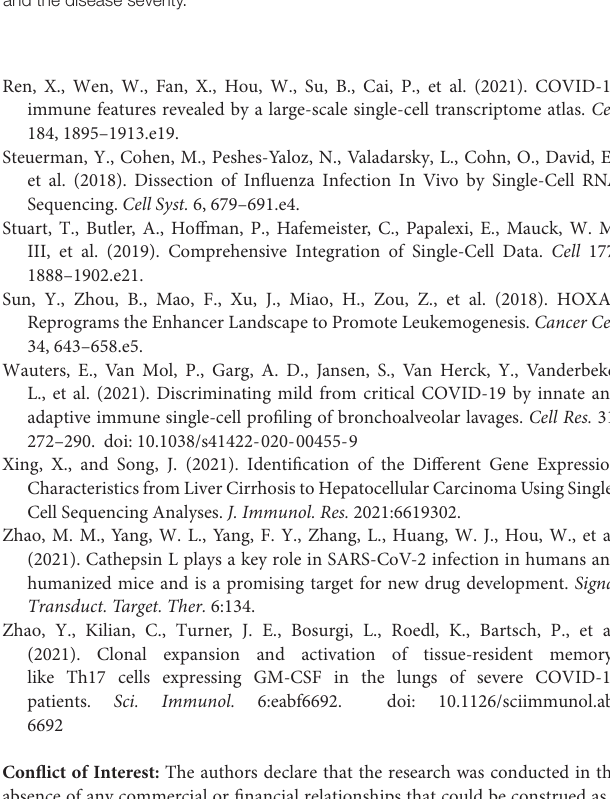
downregulated genes in severe ARDS. Genes labeled with light blue text were positively correlated with the SARS-CoV-2 infection. Supplementary Figure 6 | Gene expression in SARS-CoV-2–infected epithelial cell lines. (A) Violin plots demonstrating the expression patterns and levels of the in vivo SARS-CoV-2 infection-related PPI hub genes in the SARS-CoV-2–infected epithelial cell lines. (B) Feature plots revealing the relationship between COVID-19-related genes and in vivo SARS-CoV-2 infection-related PPI hub genes in the SARS-CoV-2–infected epithelial cell lines. Supplementary Figure 7 | Overlapping of in vivo and in vitro gene expression and disease severity. (A) A heat map demonstrating the expression levels of the contra-regulated genes of in vivo and in vitro SARS-CoV-2 infection-related genes that were shared with genes occurring in severe ARDS. (B) A flow chart demonstrating the analysis strategy of screening the virus-promoting and defense genes by combining the information from in vivo and in vitro gene expression data and the disease